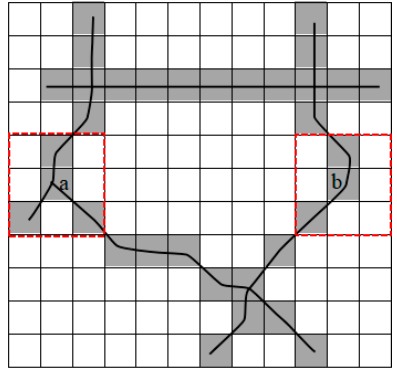
Figure 3. Intersection recognition example.